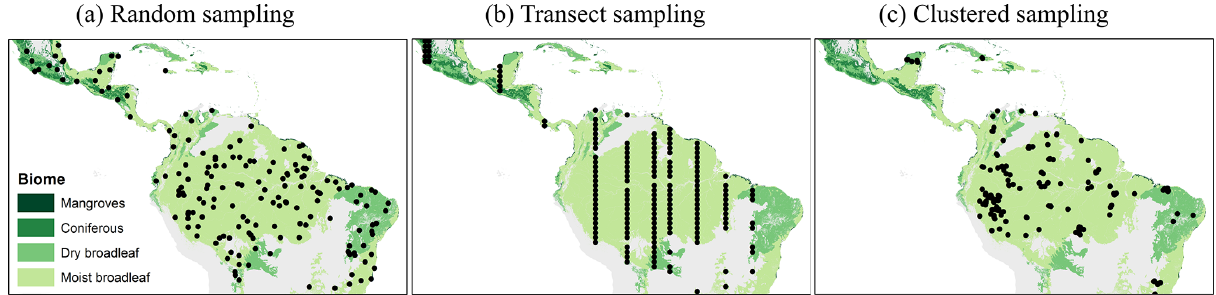
Figure 2. Examples of different simulated sampling strategies for South America (colors indicate the tropical biome). Each black dot represents the location of one selected plot (25ha). (a) Randomly distributed plots. (b) Transect samples (shown are strips with distances of 100km between the plots). (c) Clustered samples (reconstructions of